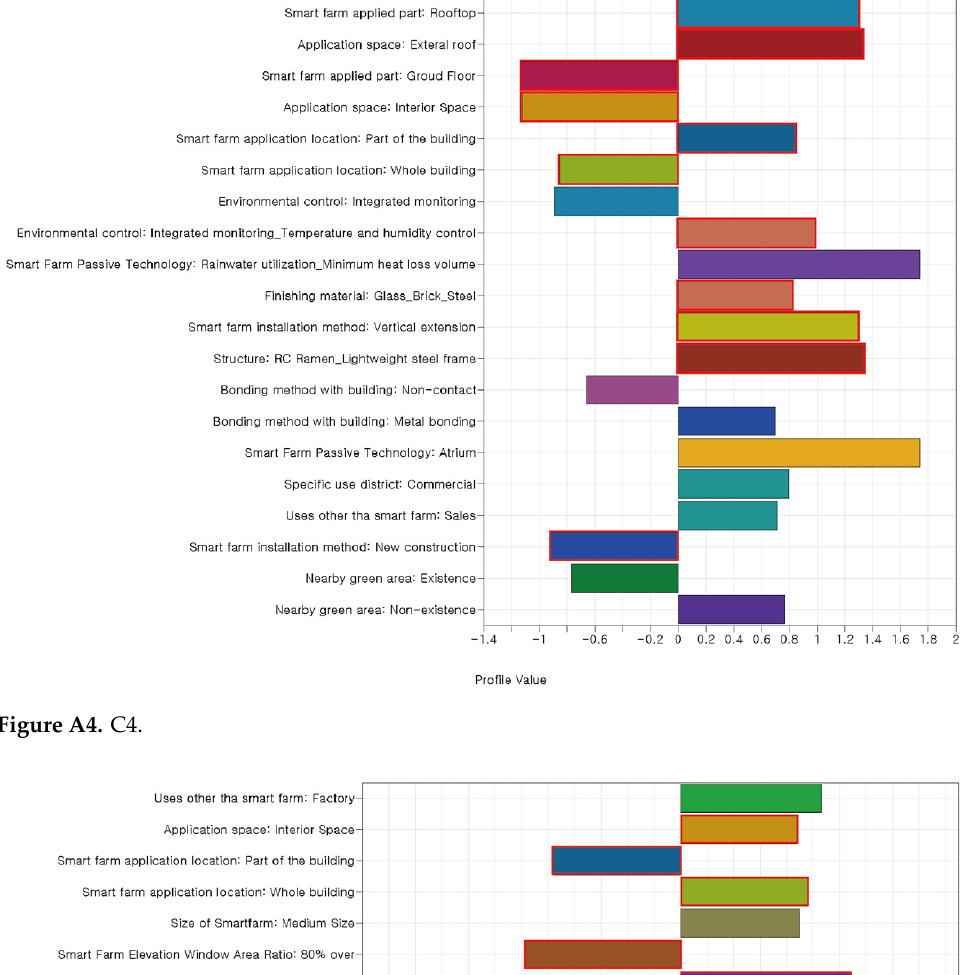
Figure A4. C4. Figure A4. C4.